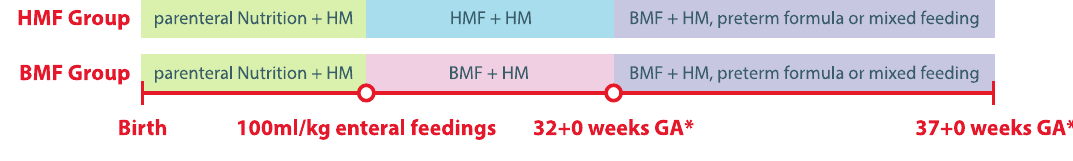
Figure 1. Feeding regimen of the study groups. *) GA = gestational age corrected for prematurity; HM = Human milk, BMF = bovine based fortifier, HMF = human milk-based fortifier.